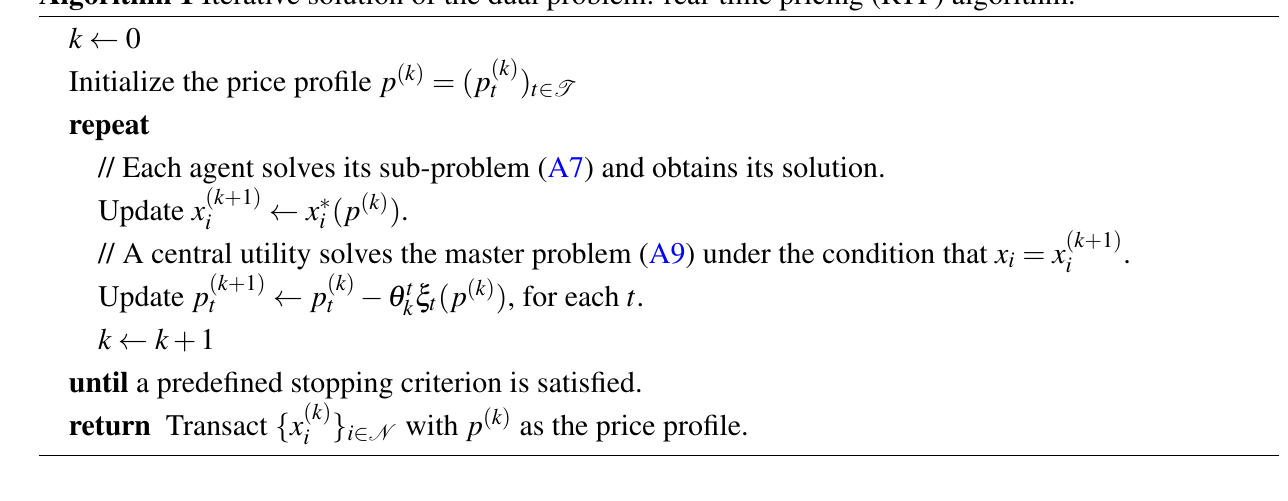
Algorithm 1 Iterative solution of the dual problem: real-time pricing (RTP)